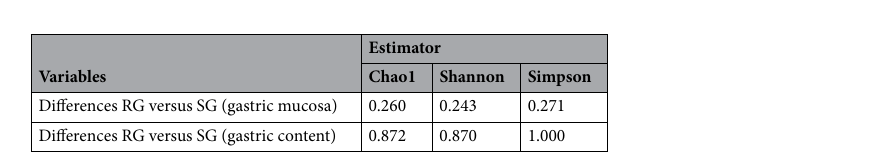
Table 3. p values between RG and SG for each estimator and each